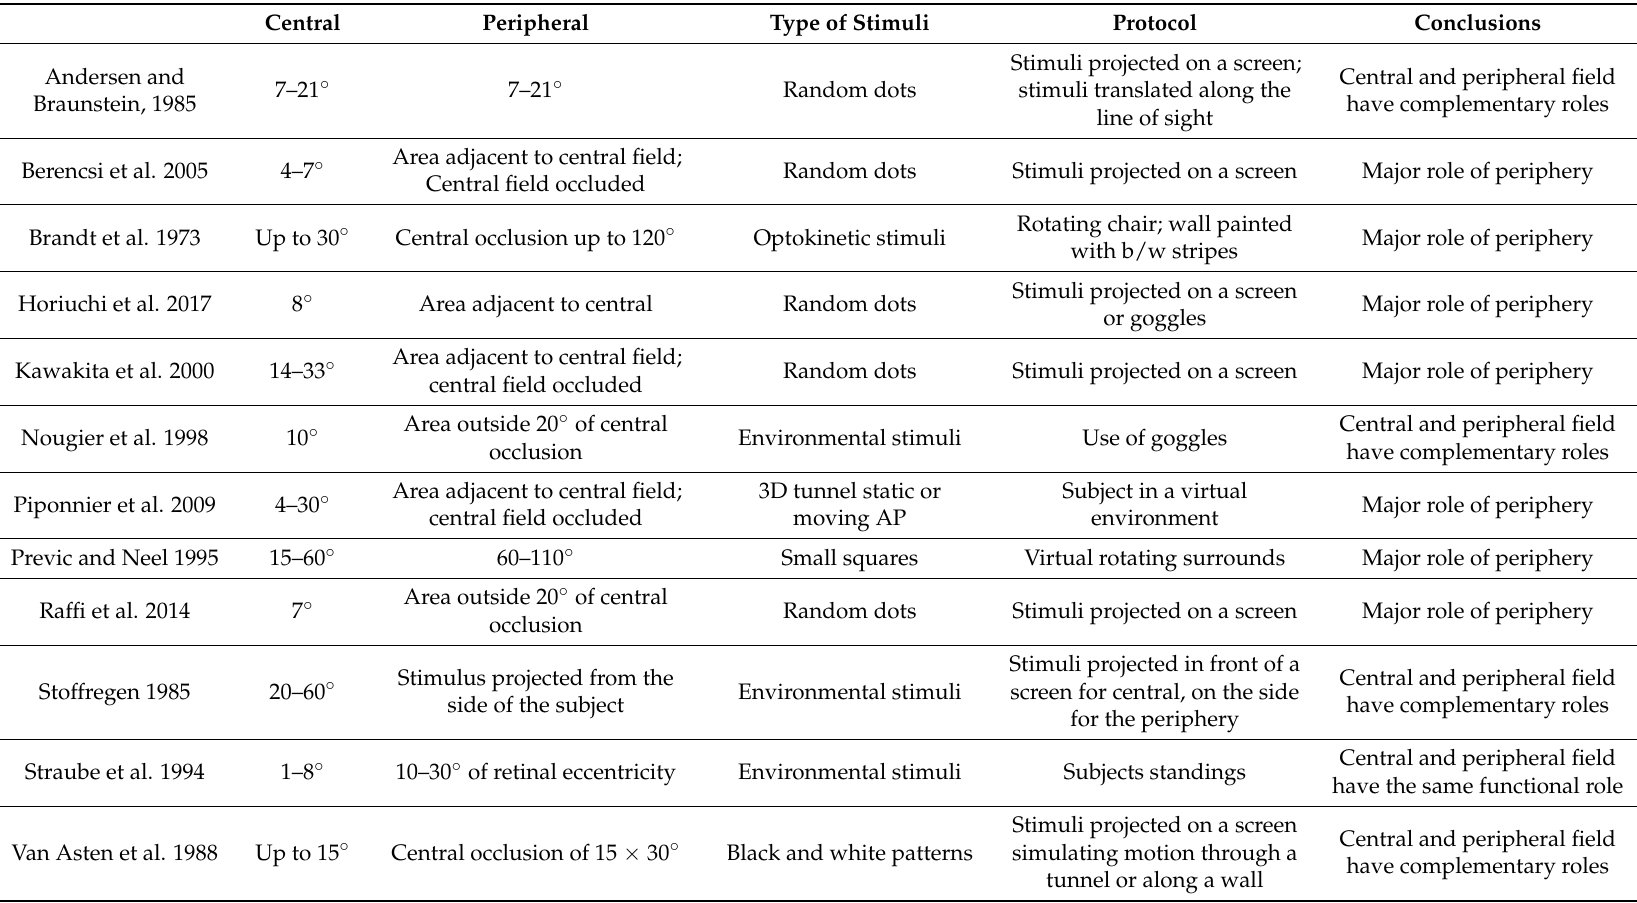
Table 1. Comparison of methodologies and definition criteria across